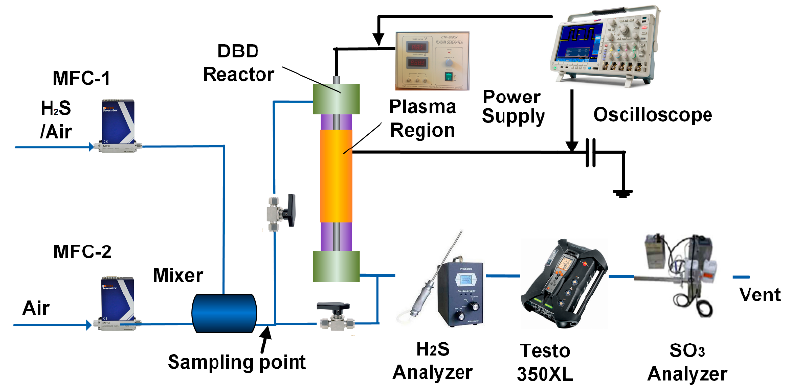
Figure 6. Schematic diagram of the experimental setup.